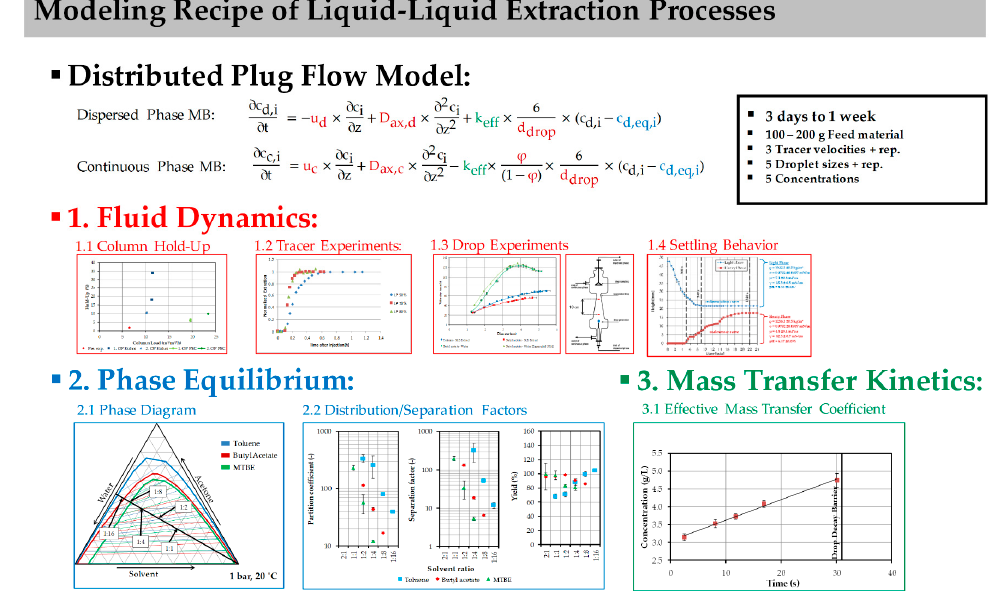
Figure 5. Modeling and parameter determination recipe scheme for liquid-liquid extraction processes.